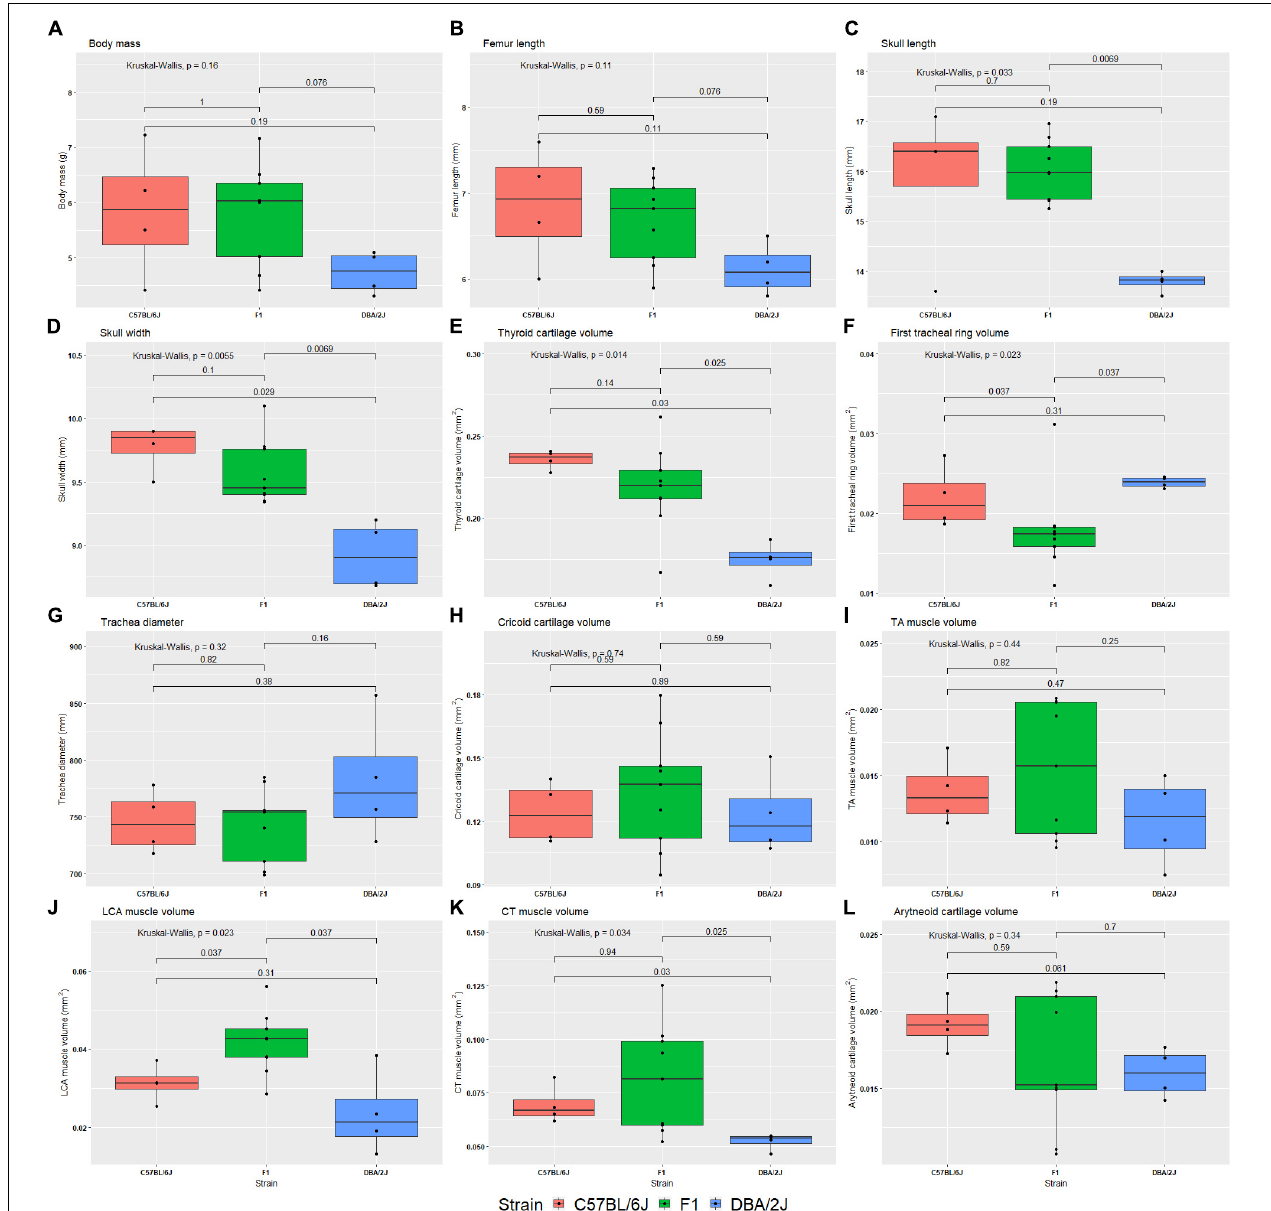
FIGURE 5 | Box plots of 12 morphological phenotypes from the diallele cross. The reciprocal F1s are presented as a single group, because no significant difference was detected between the two for any of the morphological traits. The Kruskal–Wallis test was used to calculate the significance of the effect of strain (top left of each plot), whereas the Wilcox test was used to calculate pairwise differences between strains. Morphological phenotypes are body mass (A) , femur length (B) , skull length (C) , skull width (D) , thyroid cartilage volume (E) , first tracheal ring volume (F) , trachea diameter (G) , cricoid cartilage volume (H) , thyroarytenoid muscle volume (I) , lateral cricoarytenoid muscle volume (J) , cricothyroid muscle volume (K) , and arytenoid cartilage volume (L)